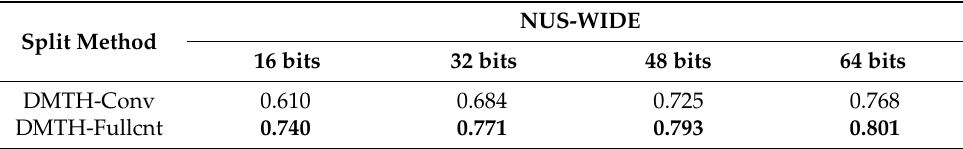
Table 2. Multi-task learning split validation experiments on